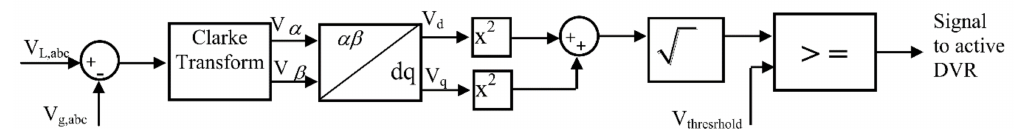
Figure 5. The structure of the voltage sags/swells